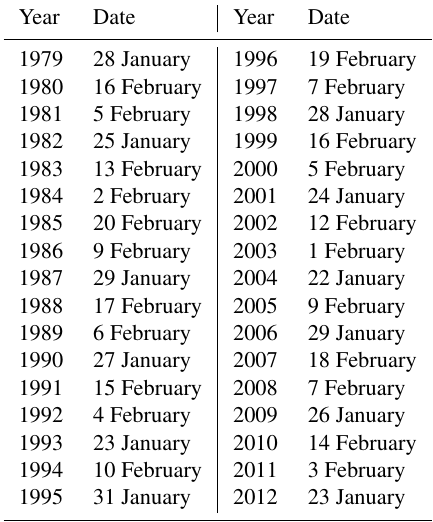
Table 1. The Lunar New Year days from 1979 to